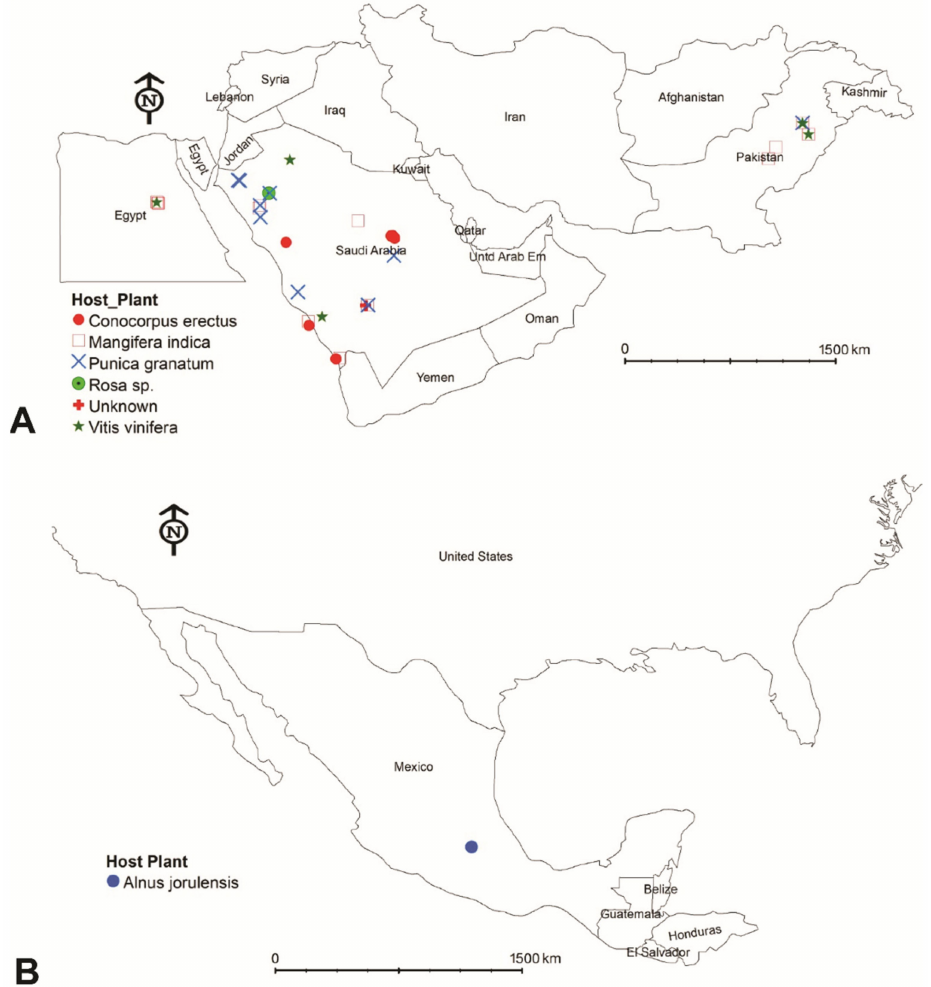
Figure 1. Geographical distribution of the ( A ) 39 spider mite samples of the punicae complex along with the ( B ) sample of claimed Mexican Oligonychus punicae [37], collected from Egypt, Mexico, Pakistan and Saudi Arabia and seven host plants ( Alnus jorulensis , Conocorpus erectus , Mangifera indica , Punica granatum , Rosa sp., Unknown and Vitis vinifera ) in the present study (ARCGIS 10.5., esri.com computer software, Esri TM , Redlands, CA,